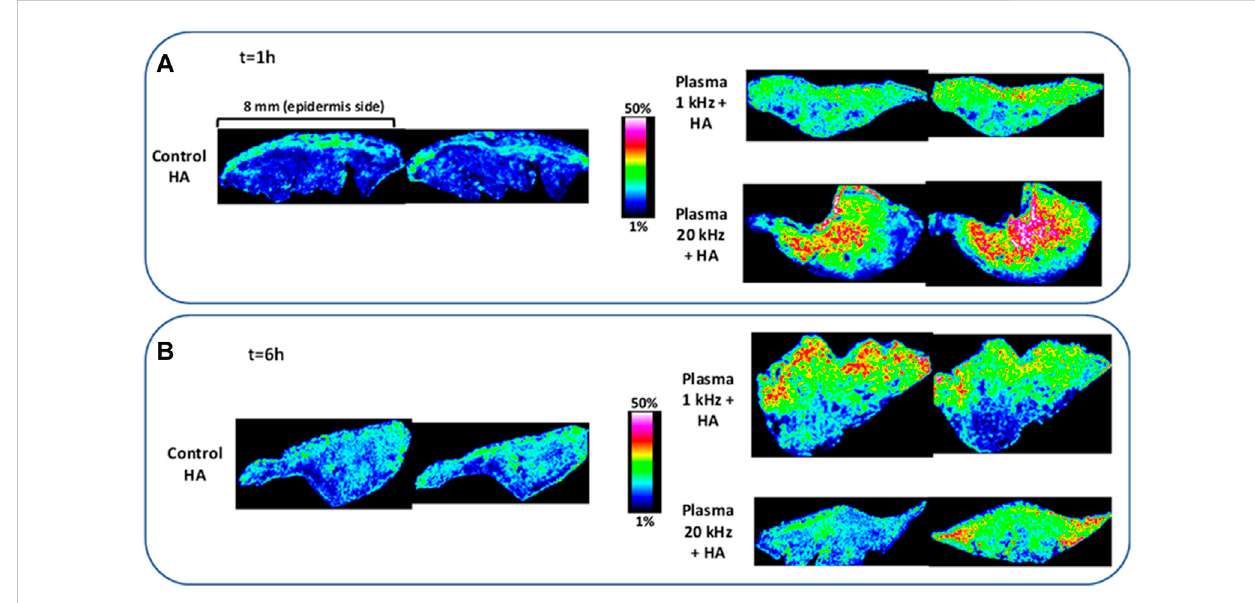
MS-MALDI skin slice images (two imagesfor each condition) for (A) (top)left: control (no plasma and topical HA application for 1 h, right up: 1k100s, and right bottom: 20k50s plasma treatment and HA topical application for 1 h. (B) (bottom) left: control (no plasma and topical HA application for 6 h, right up: 1k100s, and right bottom: 20k50s plasma treatment and HA topical application for 6